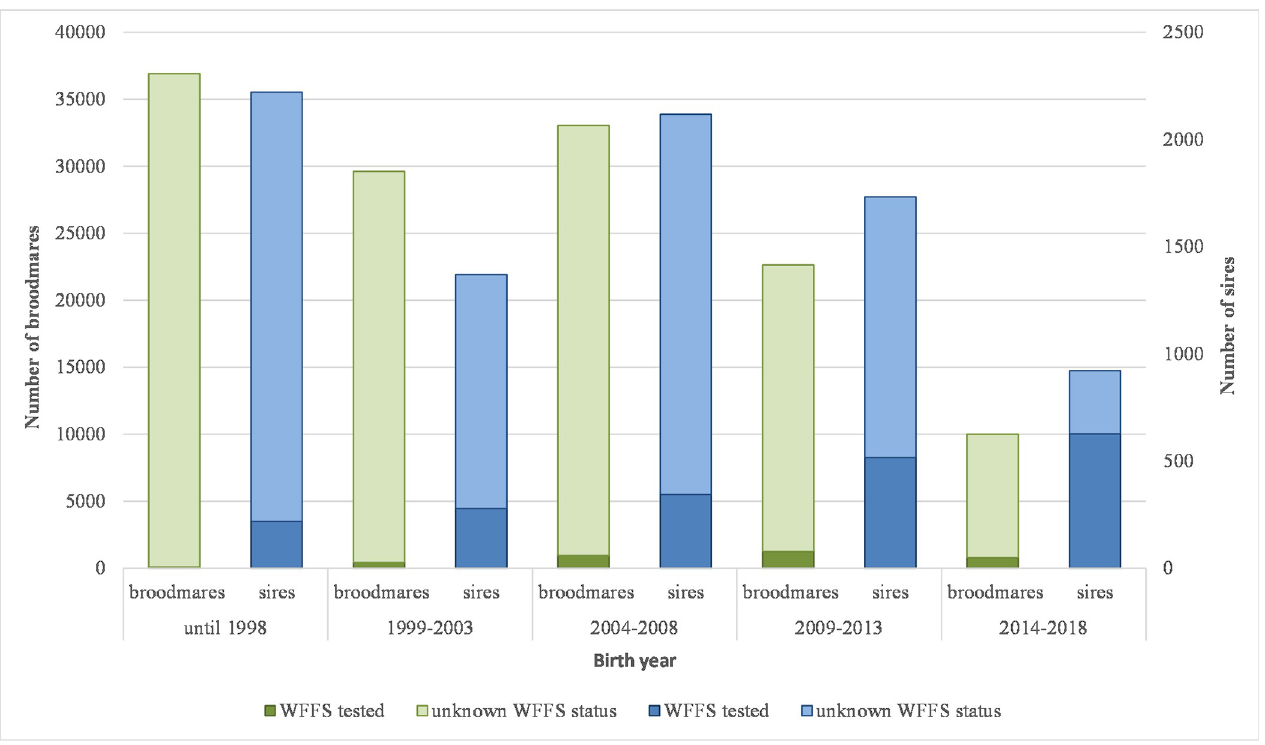
Fig 2. Proportion of horses with known WFFS test results by sex and birth year. The study sample included 8,359 sires (born in 1961–2018) and 132,188 broodmares (born in 1978–2018), which had records in the covering data of ten German horse breeding associations in the study period (2008–2020).